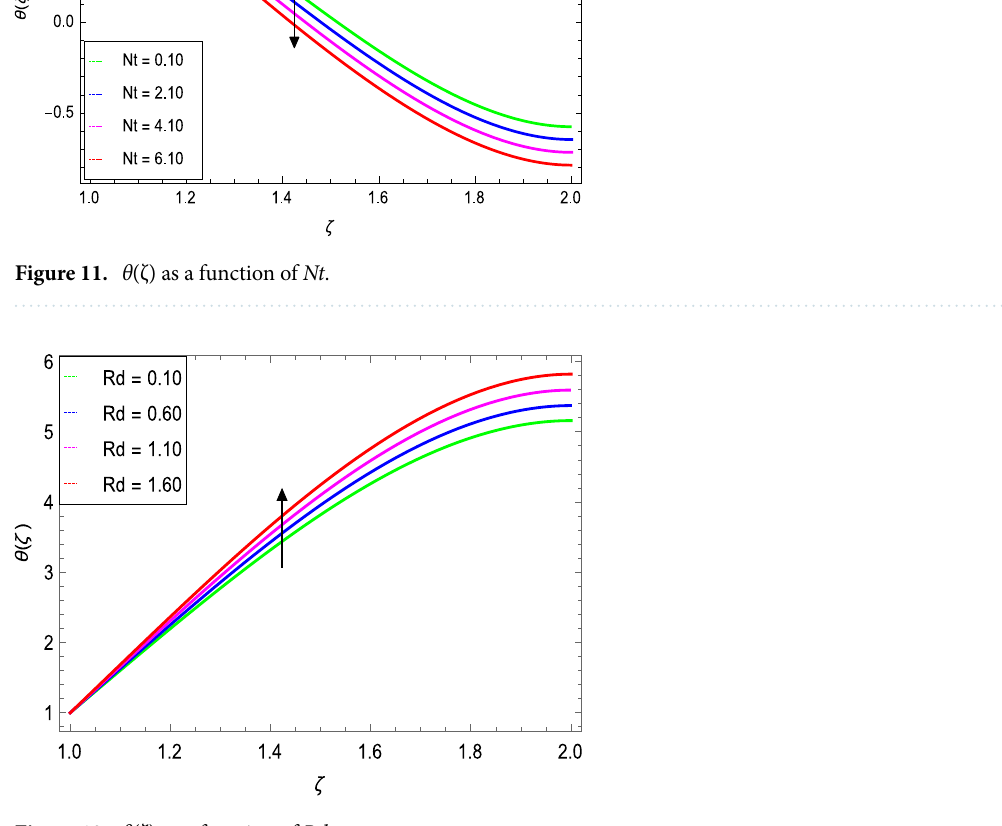
Figure 12. θ (ζ) as a function of Rd .